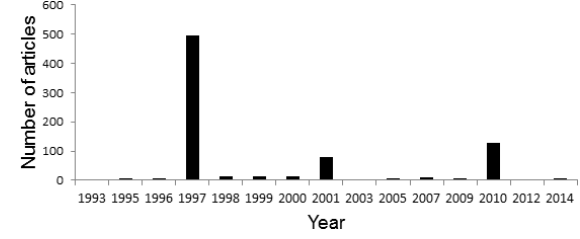
Fig. 3 . Number of articles per year in